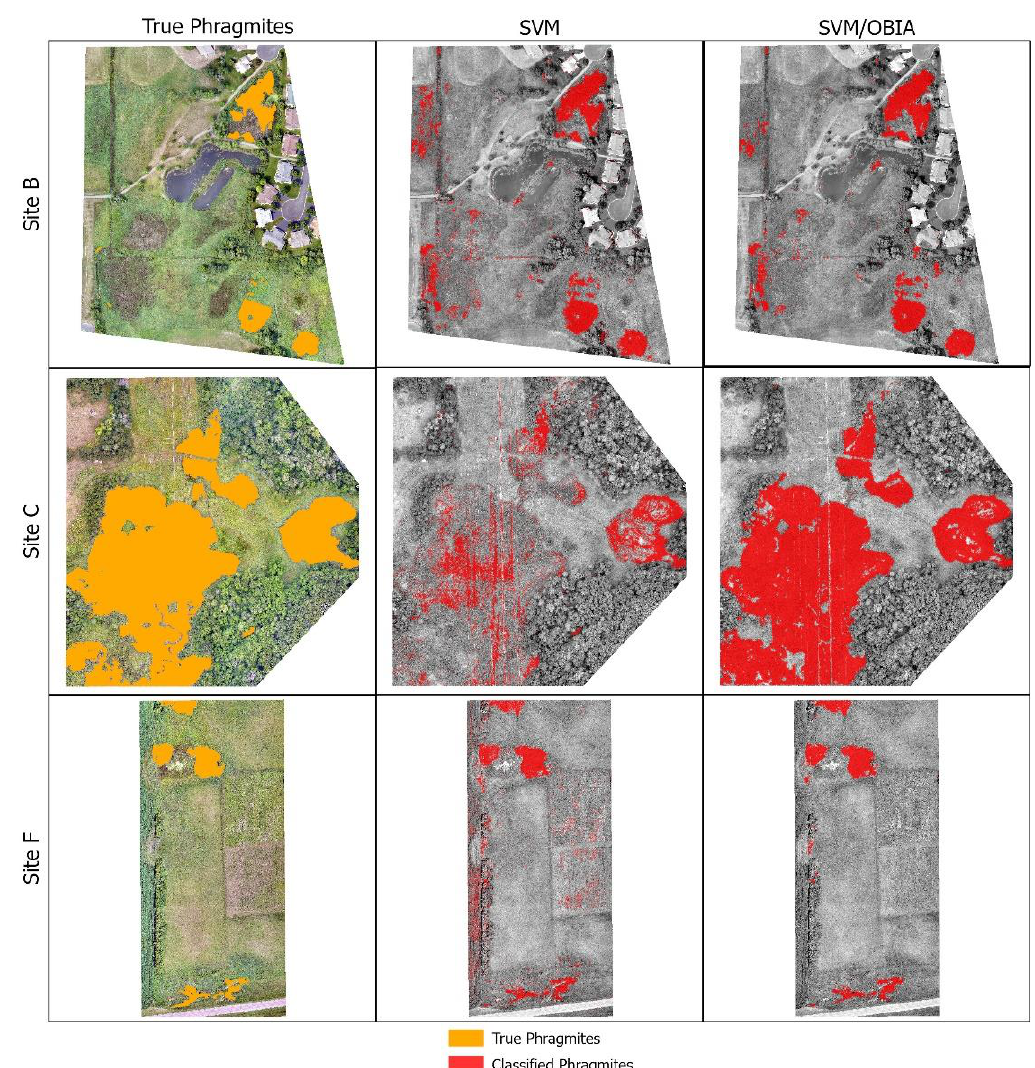
Figure 13. Classification of Phragmites (red) using a support vector machine with and without the post-ML OBIA rule set at the three validation sites: Delano City Park (B), Chisago City property (C), and the Swan Lake Wildlife Management Area (F). Everything not identified as Phragmites was classified as Not Phragmites . The true Phragmites location is provided as a reference (orange). Table 18. Validation assessment points for each of the three validation sites for the support vector machine classification without the post-ML OBIA rule set.